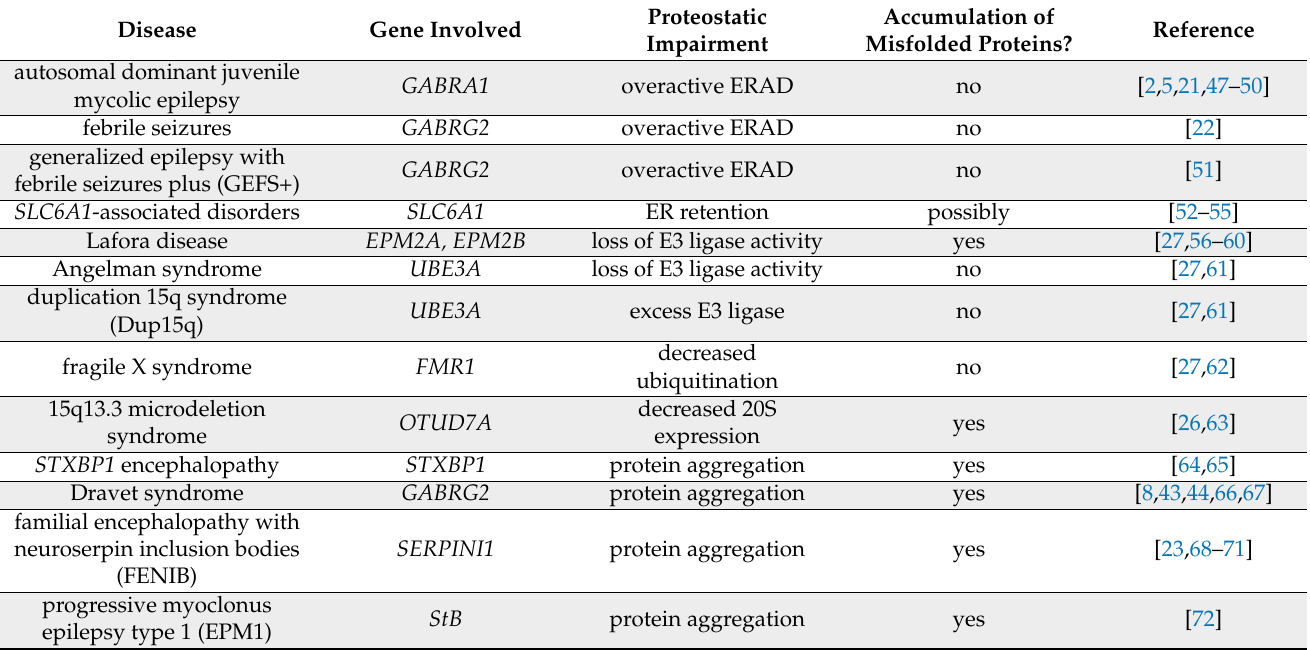
Table 1. Proteostatic impairments in genetic epilepsies and neurological disorders with comorbid seizures. Proteostatic Accumulation of Disease Gene Involved Impairment Misfolded Proteins?